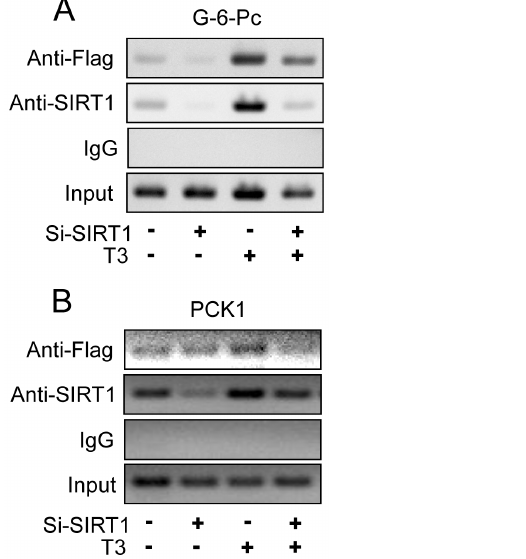
Figure 9. SIRT1 is recruited to TREs of TR b 1 target genes. ChIP assays performed in HepG2-TR b cells treated + / 2 SIRT1 siRNA and T 3 . Antibodies used for immunoprecipitation were Flag, SIRT1 or IgG control. 10 % (v/v) of the supernatant was represented as ‘input’ chromatin prior to immunoprecipitation by antibodies.